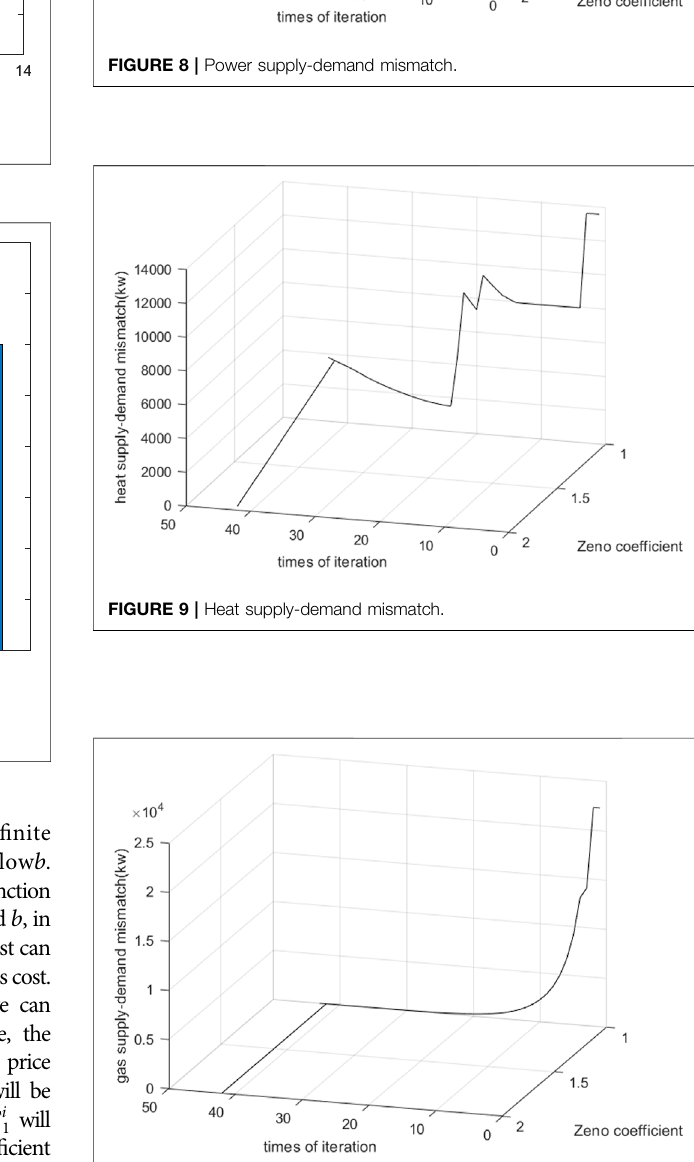
FIGURE 10 | A gas supply-demand